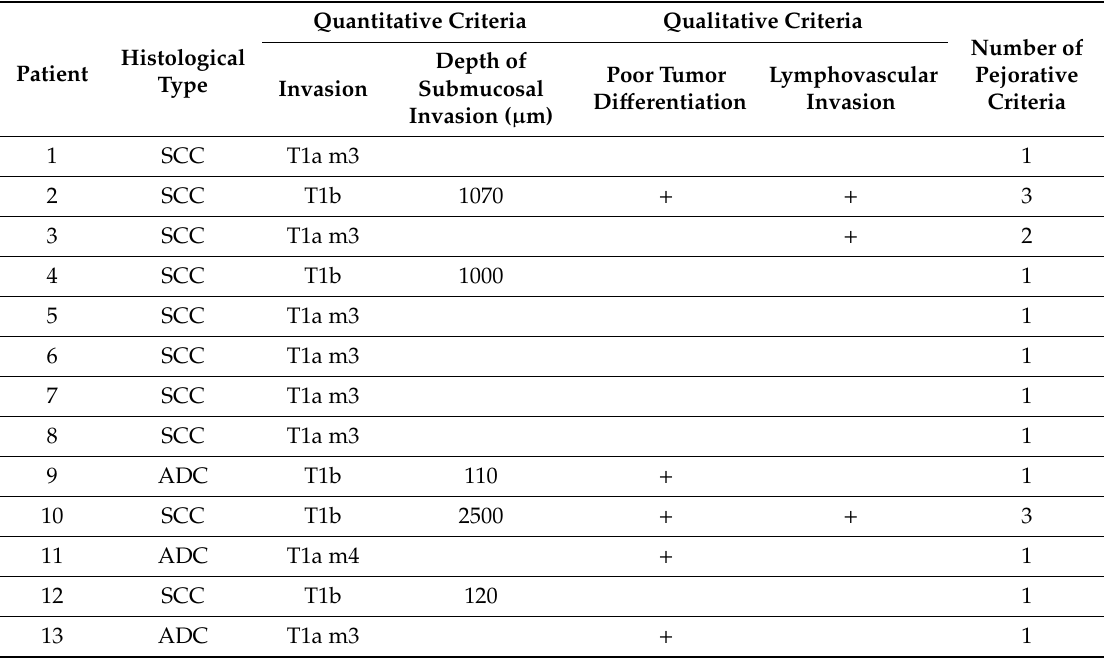
Table 2. Histological characteristics of the lesions in the 13 patients of the close follow-up group. Quantitative Criteria Qualitative Criteria Number of Histological Depth of Patient Pejorative Poor Tumor Lymphovascular Type CriteriaInvasion Submucosal Di ff erentiation Invasion Invasion ( µ m) 1 SCC T1a m3